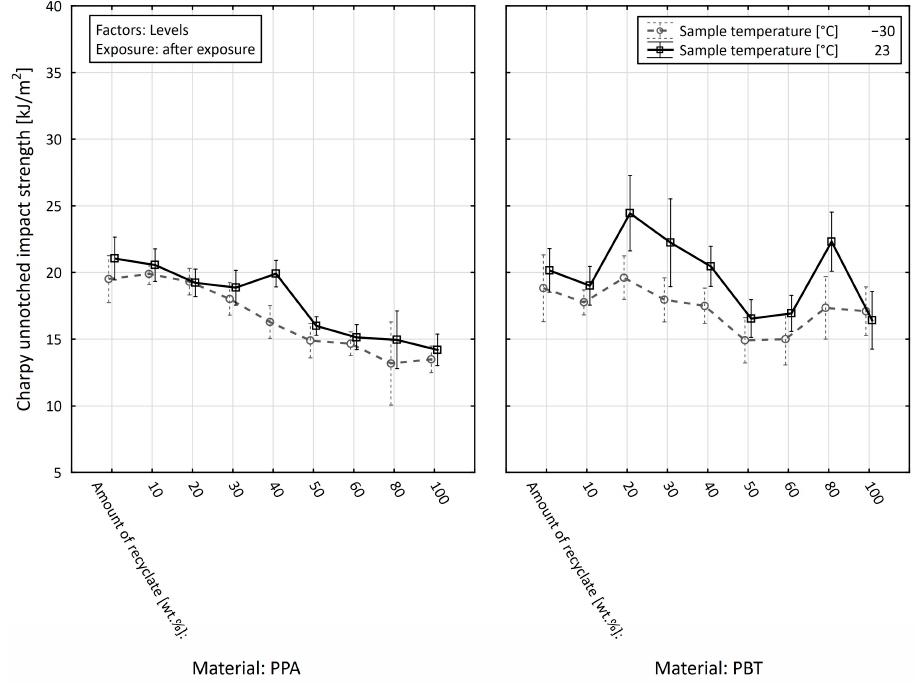
Figure 16. Effect of the materials on the impact test value of the unnotched impact strength depending on the amount of the recycled material and the specimen temperature after the exposure. When, in the same way, we analyzed the value of the notch toughness, a cU (kJ · m − 2 ), between the PPA and PBT materials in the state after the exposure, we arrived at the conclu- sion that the difference between the studied materials (PPA and PBT) reached an average value of − 3.484 kJ · m − 2 , which led us to a similar conclusion that the notch toughness value of PBT is on average higher than that of the PPA materials. However, in the state after the ex- posure, we found significantly higher differences than in the previous case. The maximum value of the difference in unnotched impact strength ( − 9.925 ± 2.604 kJ · m − 2 ) was recorded when the recyclate accounted for 100 wt.% and the specimen temperature was +23 ◦ C. In terms of the sizes of the differences, the second most significant, when the recyclate ac- counted for 50 wt.% and the specimen temperature was +23 ◦ C ( − 9.420 ± 2.203 kJ · m − 2 ), was followed by the difference when the recyclate accounted for 60 wt.% and the speci- men temperature was +23 ◦ C ( − 7.160 ± 2.030 kJ · m − 2 ), the difference when the recyclate accounted for 60 wt.% and the specimen temperature was − 30 ◦ C ( − 6.915 ± 1.721 kJ · m − 2 ), and the difference when the recyclate accounted for 100 wt.% and the specimen temper- ature was − 30 ◦ C ( − 6.588 ± 2.254 kJ · m − 2 ). It was also interesting that at lower levels of the recycled material, in most cases, the differences were statistically insignificant. When the recyclate accounted for 0 wt.%, the difference value with a specimen temperature of − 30 ◦ C was − 0.465 ± 2.335 kJ · m − 2 , and with a specimen temperature of +23 ◦ C it was 0.445 ± 2.394 kJ · m − 2 . When the recyclate accounted for 20 wt.% and the specimen